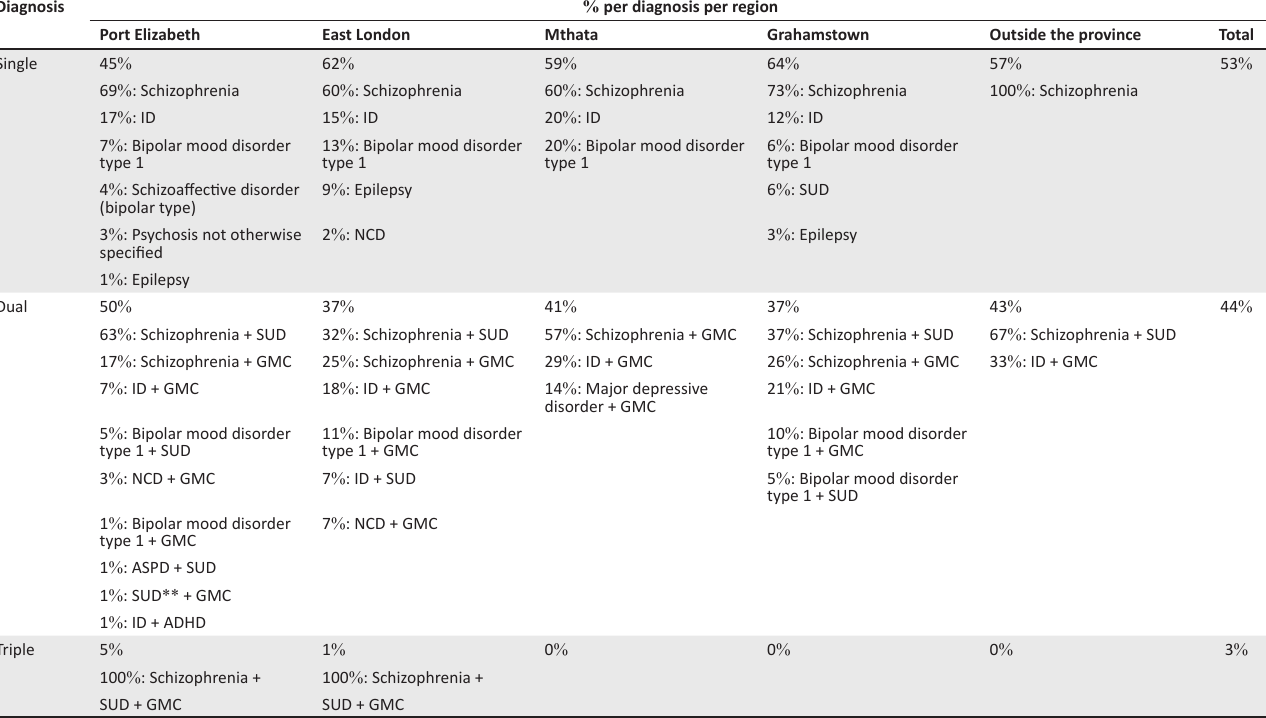
TABLE 5: Diagnosis of male patients at admission to Tower Psychiatric Hospital and Psychosocial Rehabilitation Centre. Diagnosis % per diagnosis per region Port Elizabeth East London